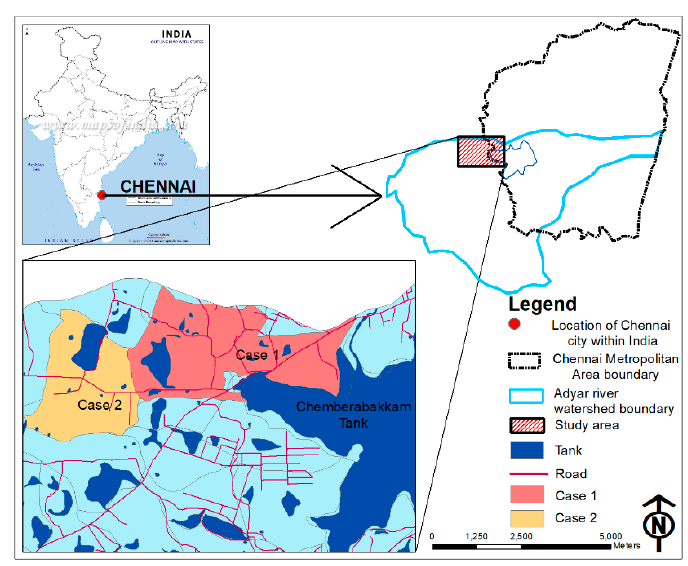
Figure 3. Study area location.